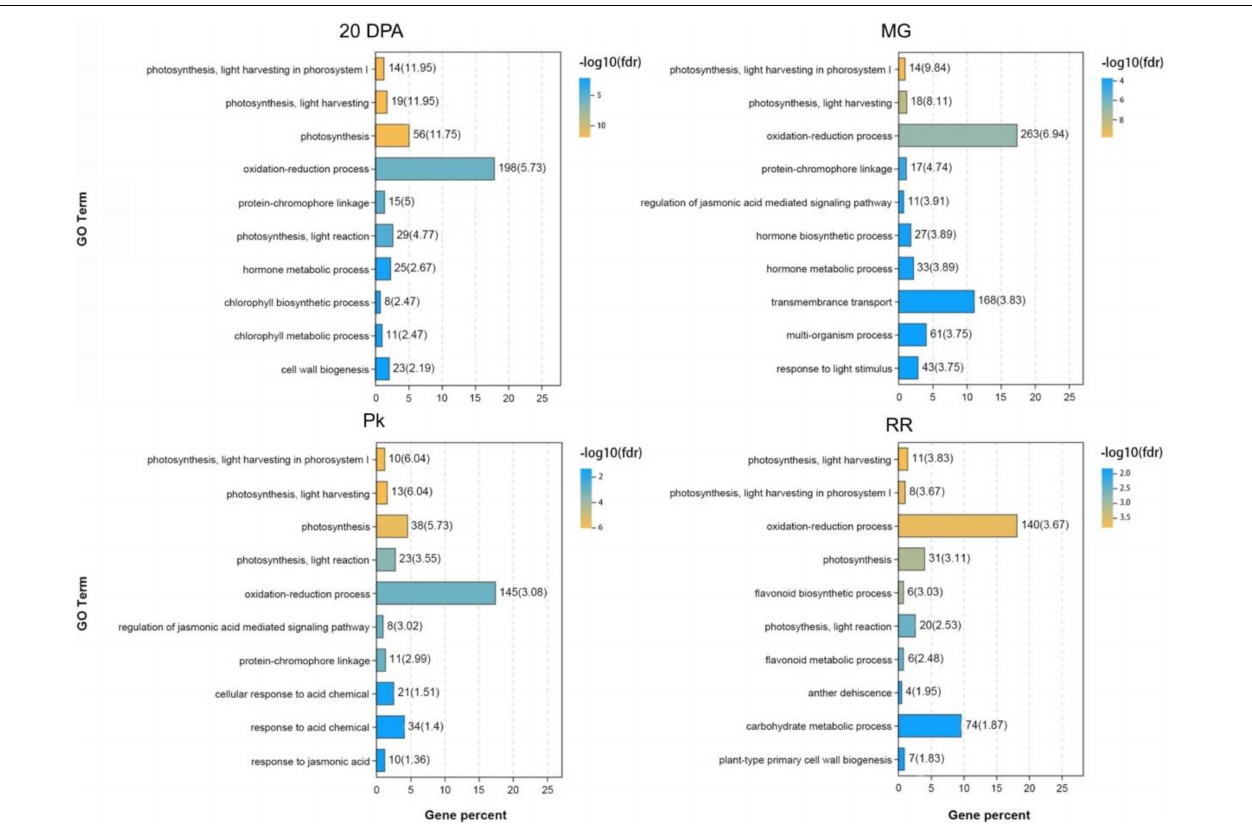
FIGURE 9 | Gene ontology (GO) analysis of DEGs between WT and OE-3 at different development stages. The vertical axis indicates the GO Terms with –log10(fdr) ranking top 10. The horizontal axis indicates the gene percent among the DEGs.